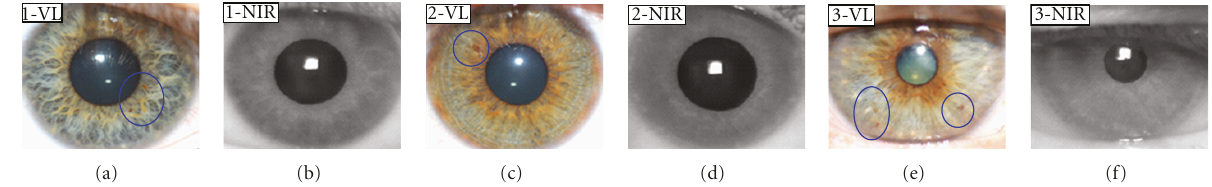
Figure 1: Three pairs of VL and NIR iris images from three di ff erent subjects. The regions highlighted by the blue circles contain some pigment information that is not visible in the corresponding regions of the NIR